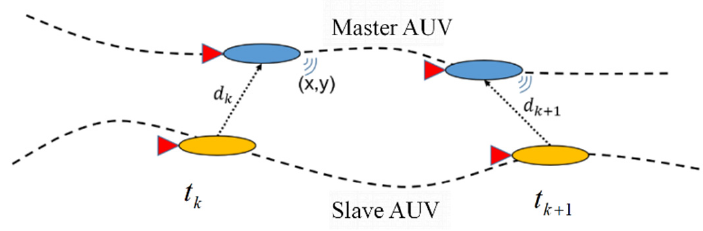
Figure 2. Two-AUV cooperative navigation process.